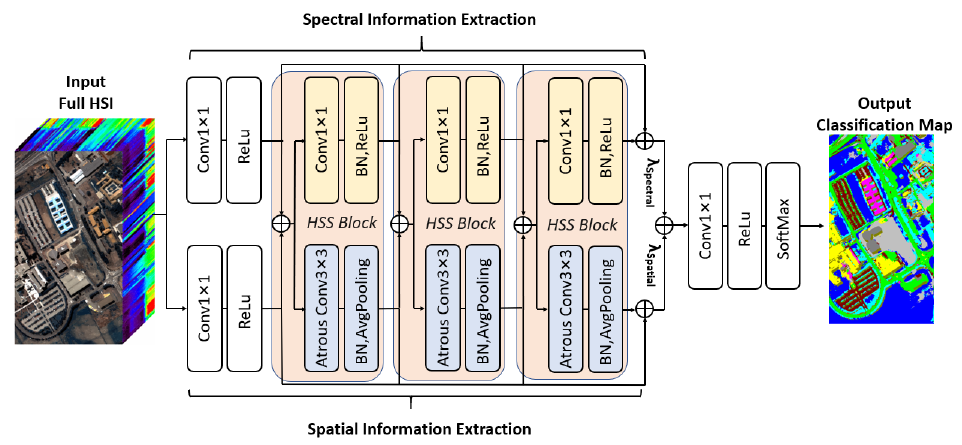
Figure 3. The architecture of the proposed TFNet for HSI classification. The information extracted by the spectral branch and spatial branch were fused by stacked HSS blocks. The merged feature map was combined into two feature maps with weighted